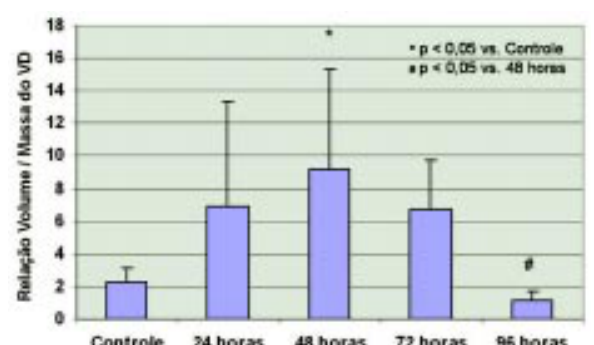
Fig. 7 - Evolução da relação volume/massa do VD ao longo do protocolo de sobrecarga sistólica intermitente, mostrando aumento significativo no momento 48 horas. N = 7. Valores (ml/g/kg) = média ± desvio padrão. * p < 0,05 vs. Controle; # p < 0,05 vs. 48